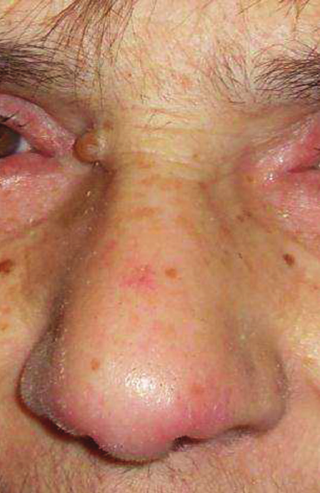
Figure 2: Swelling with features of chondritis and crusted lesions of the